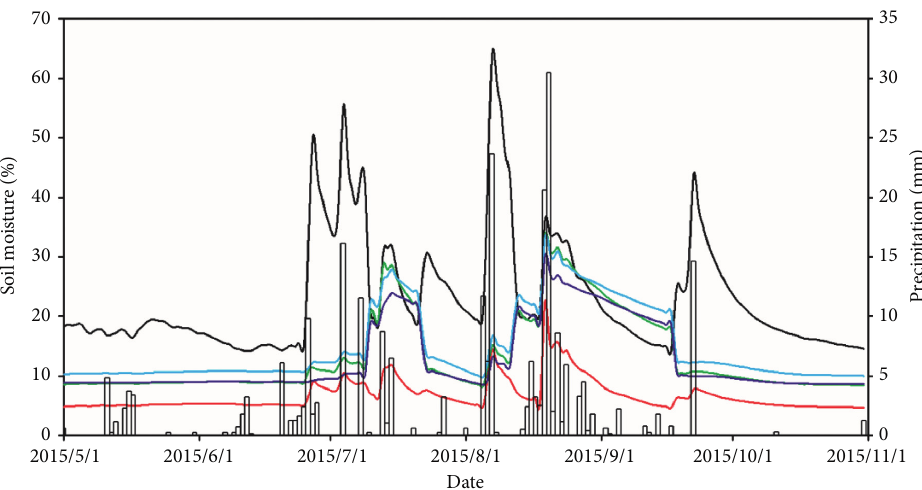
Figure 6: Precipitation and SM levels in the soil profile at Zedang from May to October 2015.